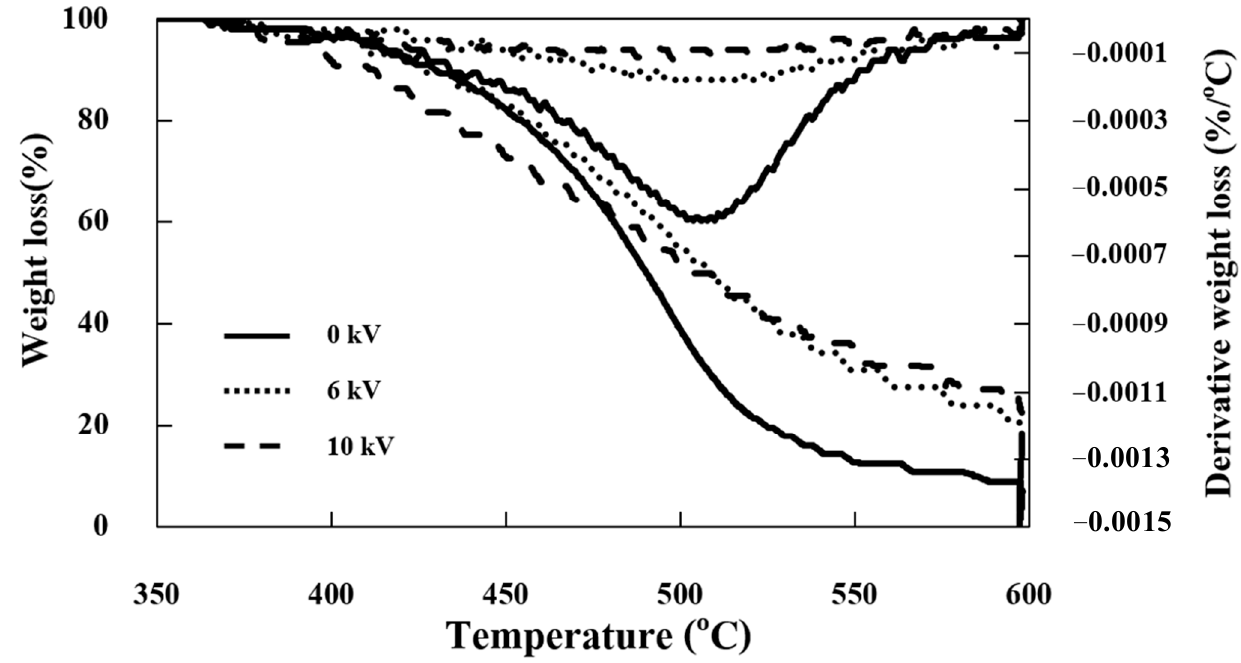
Figure 10. TGA spectra for soot before and after NTP at 2000 rpm and IMEP 6 bar. Activation Energy (Ea) to break down carbon bonds in soot. Temperature ranges from 350–600 ◦ C were selected based on the slope of the soot weight loss [30]; moisture and VOC were not taken into consideration, as shown in Table 4. It was found that, when the high voltage was applied to the plasma at 6 and 10 kV, the Ea decreased by 4.94 and 19.07 kJ/mol (2.85 and 10.97%, respectively). As a result of NTP, the soot could be broken down more easily. The activation energy (Ea) can be calculated from Equation (36).